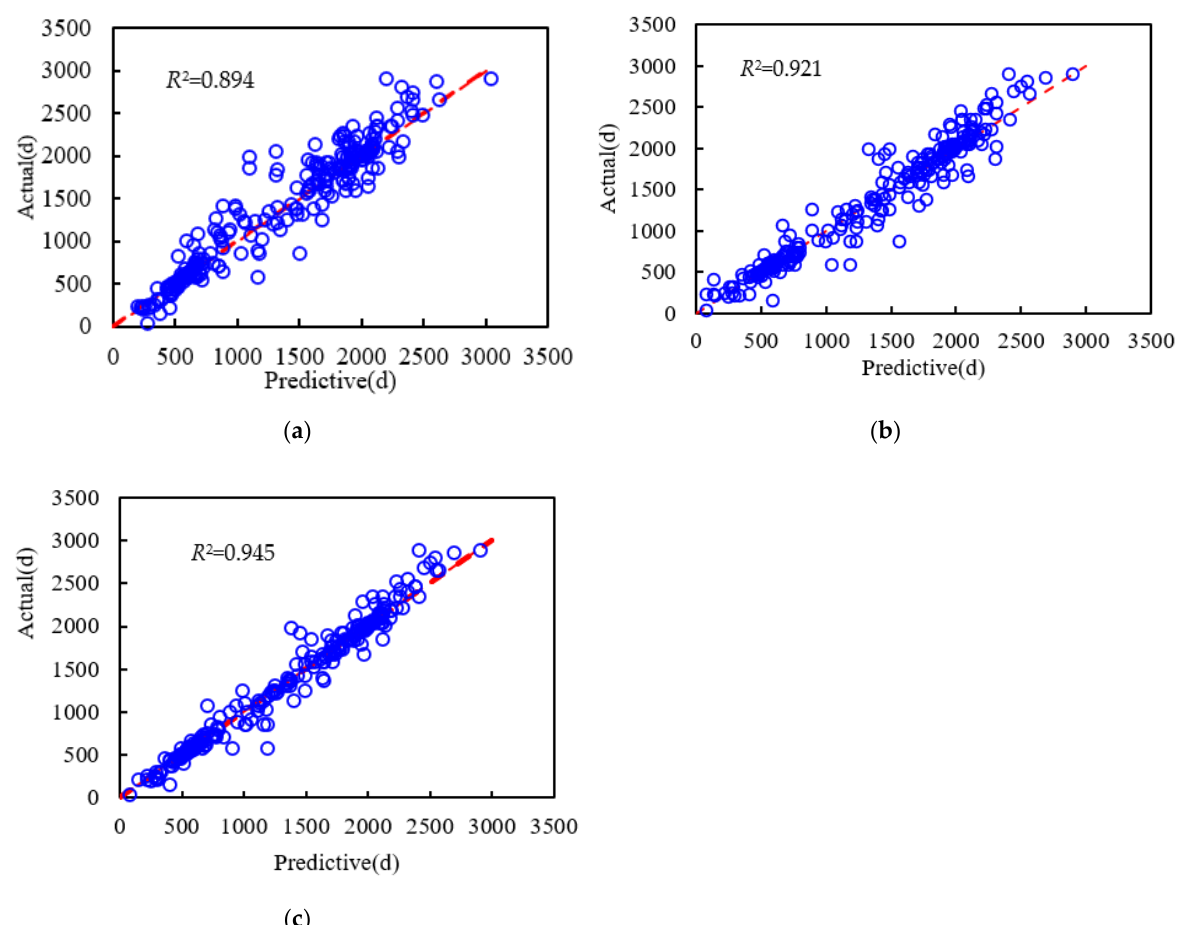
Figure 10. Intersection diagram of simulation data and verification data: ( a ) SVR; ( b ) XGBoost; ( c ) integrated learning algorithm.